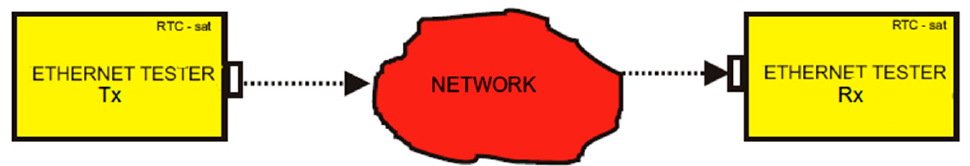
Figure 2. Dual-port testing of a single network element. Figure 3. End-to-end testing.